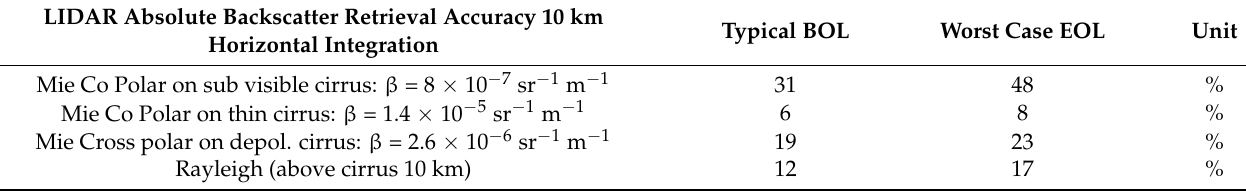
Table 3. ATLID LIDAR retrieval